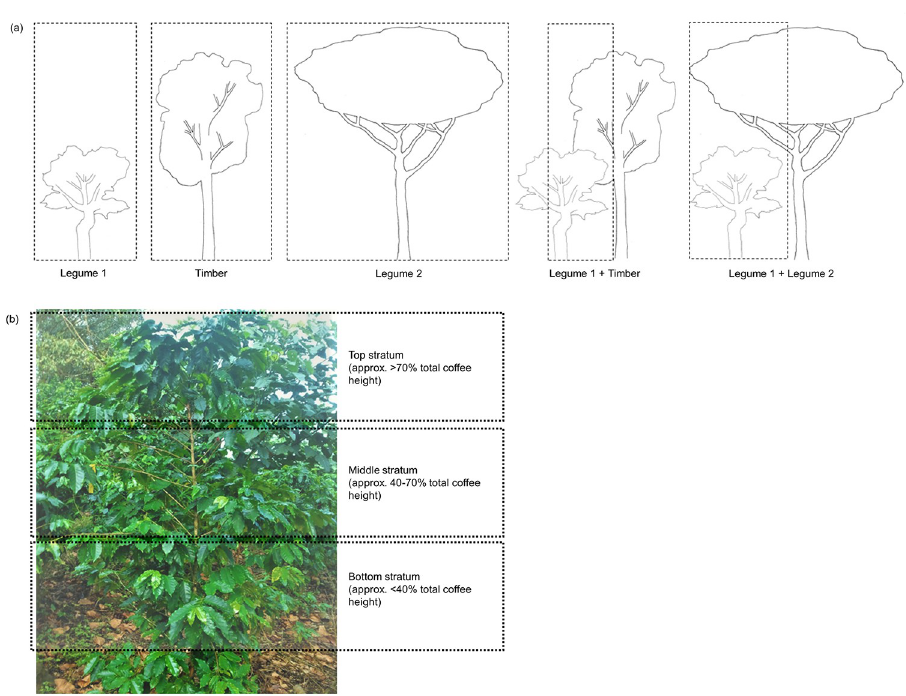
Fig 1. Plot- and plant-level sampling requirements. (a) The five shade tree treatments are represented: Erythrina poeppigiana (Legume 1), Terminalia amazonia (Timber), Chloroleucon eurycyclum (Legume 2), E . poeppigiana + T . amazonia (Legume 1 + Timber) and E . poeppigiana + C . eurycyclum (Legume 1 + Legume 2). Dotted boxes represent study plot boundaries for all measurements. (b) Coffee plant profile with each of the plant strata highlighted (top, middle, bottom) from which leaves were sampled.